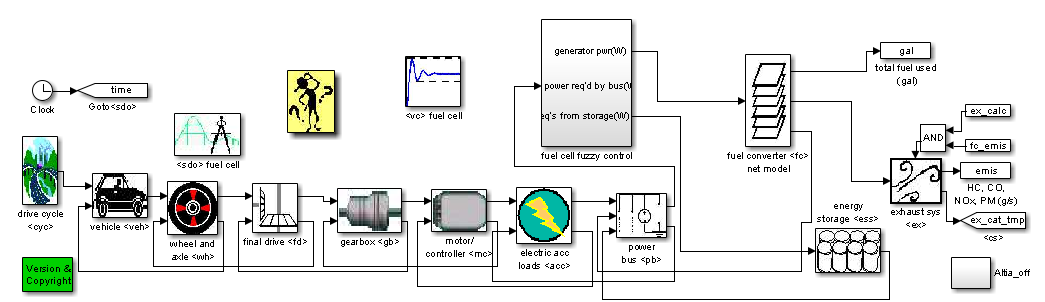
Figure 3. Simulation model of the vehicle.